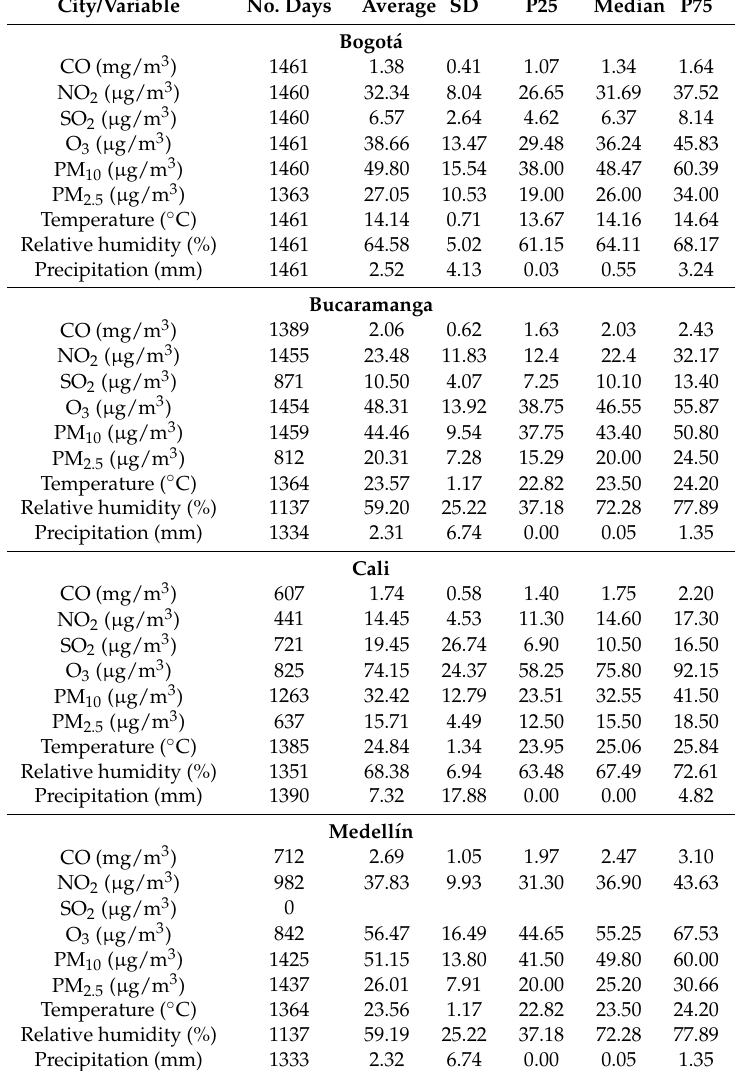
Table 2. Daily Concentrations of Pollutants and Weather Conditions in Four Cities in Colombia, 2011 to 2014.